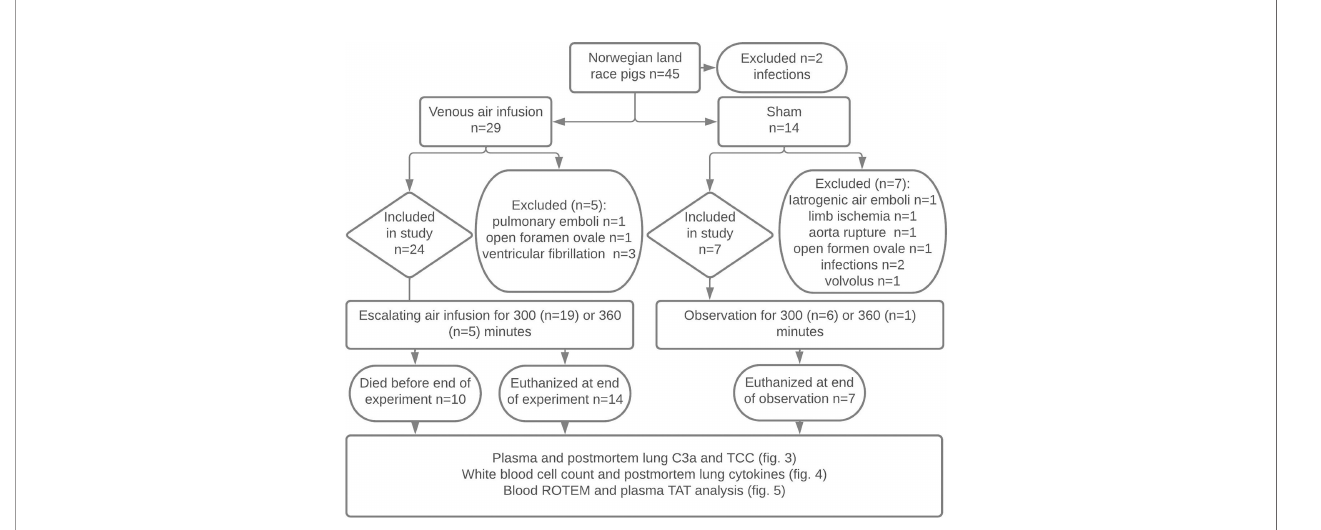
FIGURE 1 | Experimental fl owchart. Forty- fi ve Norwegian landrace pigs from two farms were selected by convenience sampling to undergo 300 or 360 minutes of titrated air infusion or serve as sham animals. Animals with infections, pulmonary emboli during animal preparation, persistent foramen ovale, ventricular fi brillation, iatrogenic venous air embolism, limb ischemia, or iatrogenic aortic rupture were excluded. Ten pigs receiving air infusion died due to the air infusion after a median infusion time of 243 minutes. Animals alive at the end of the experiments were euthanized. Blood was sampled at regular intervals throughout the experiments, and lung tissue was sampled post-mortem. Blood and lung samples were analyzed as detailed in the fi